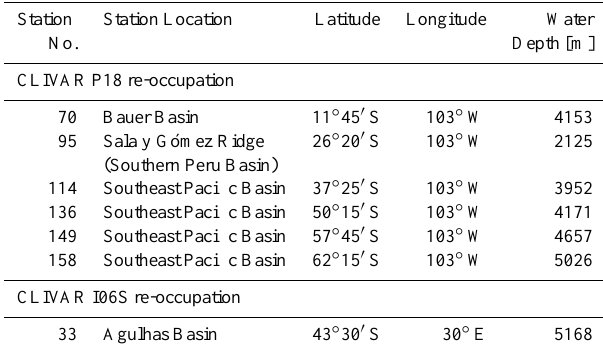
Table 1. Station locations from which samples presented in this study were collected.